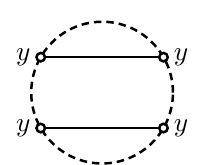
Figure 1 . Leading order disconnected contribution G (0) with other similar diagrams obtained by